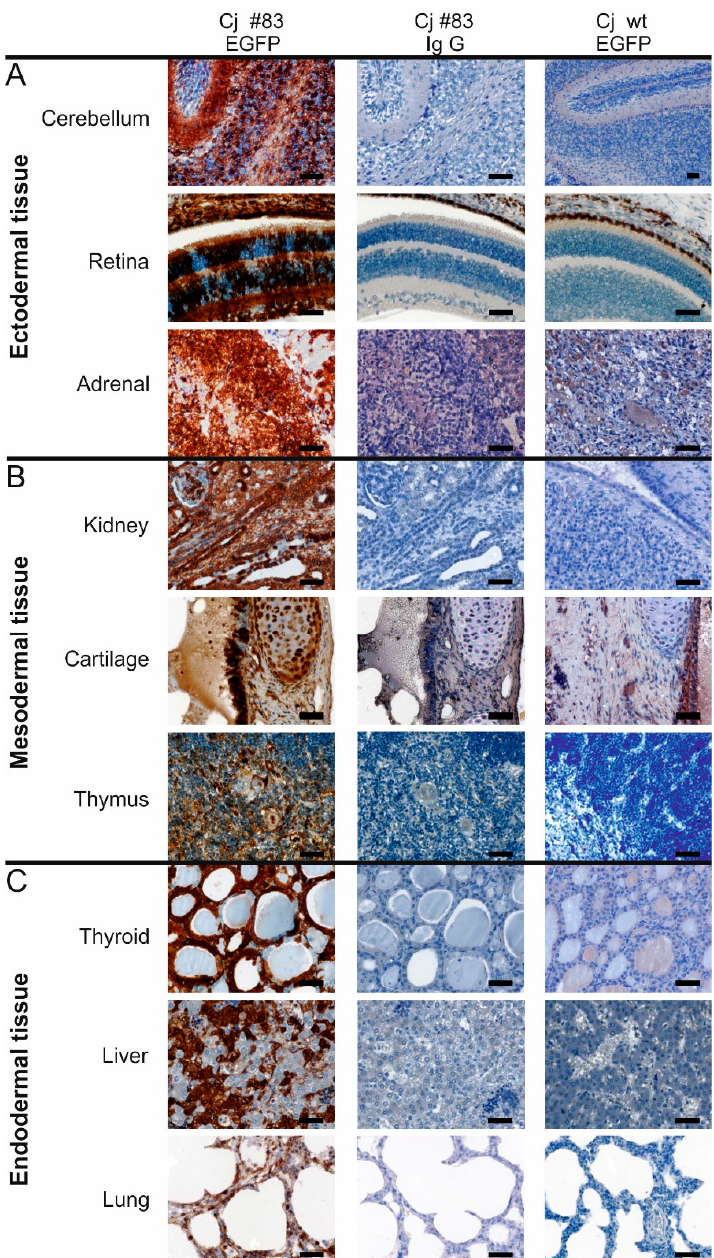
Figure 4. EGFP expression analysis in tissues of #83. Left column: images of tissues from the EGFP- transgenic animal #83 incubated with the EGFP antibody. Middle column: consecutive sections of the same samples incubated with the IgG control serum. Right column: corresponding wt samples incubated with the EGFP antibody. ( A) shows tissue samples of ectodermal, (B) of mesodermal and ( C) of endodermal origin. Scale bars: 50 µm.